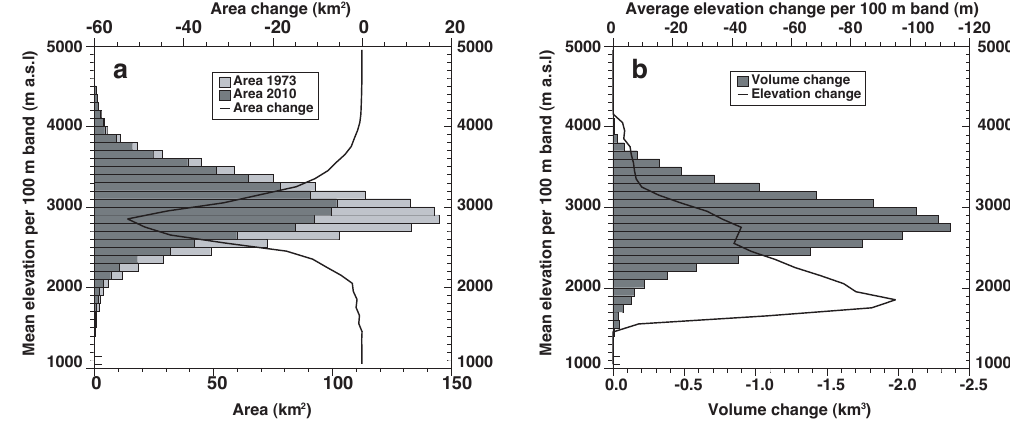
Figure 7. (a) Area-elevation distribution in 1973 and 2010 in 100m elevation bands and corresponding area changes between the two inventories. (b) Elevation distribution of the observed volume changes within the observation period as well as resulting average elevation changes per 100m elevation bands.